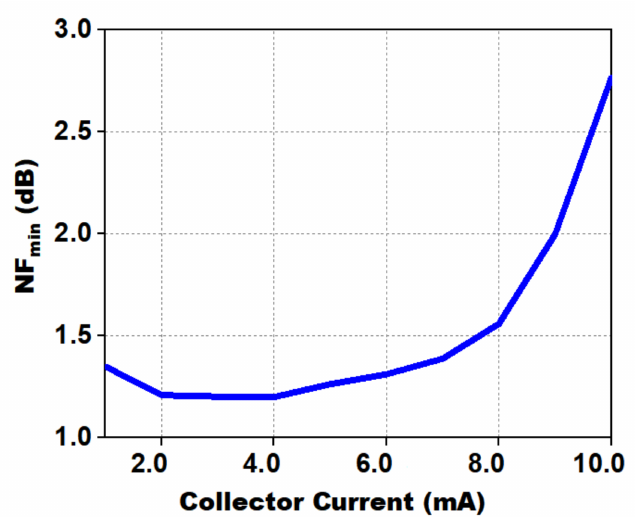
Figure 6. Simulated NF min vs. Collector Current (mA).